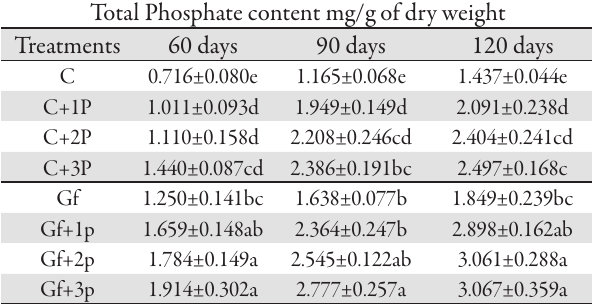
Tab. 4. Total phosphate content of Catharanthus roseus